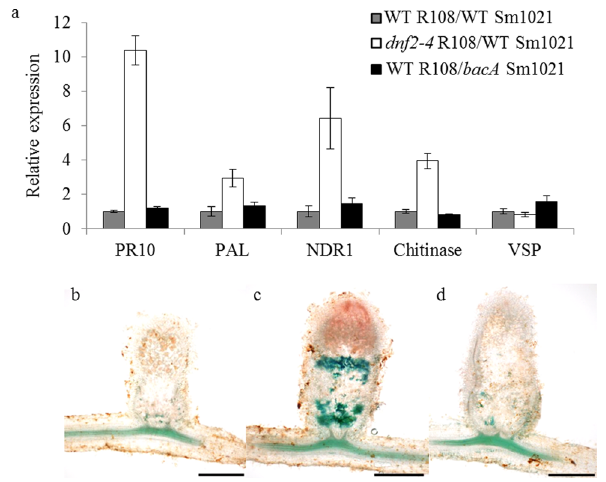
Figure 1. Bacteroid differentiation defect is not sufficient to trigger defense-like reactions in dnf2 nodules. Panel a: Expression of defense markers was evaluated by RT-qPCR using cDNA prepared from 14 dpi nodules. The y axis represents fold induction/WT. Panel b: 25 dpi nodules of R108 WT induced by Sm1021 WT. Panel c: 25 dpi nodules of dnf2–4 induced by Sm1021 WT. Panel d: 25 dpi nodules of R108 WT induced by a SM1021 bacA derivative. Nodules in b, c and d were stained for phenolics using potassium permanganate toluidine blue (scale bars 500 m m).